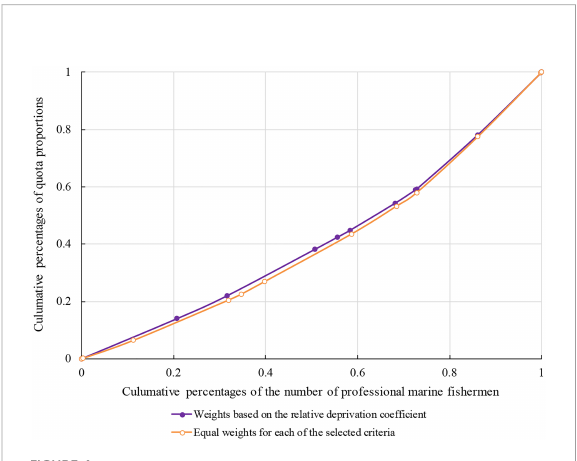
FIGURE 4 The Lorenz curves of allocation results under the multi-criteria- based